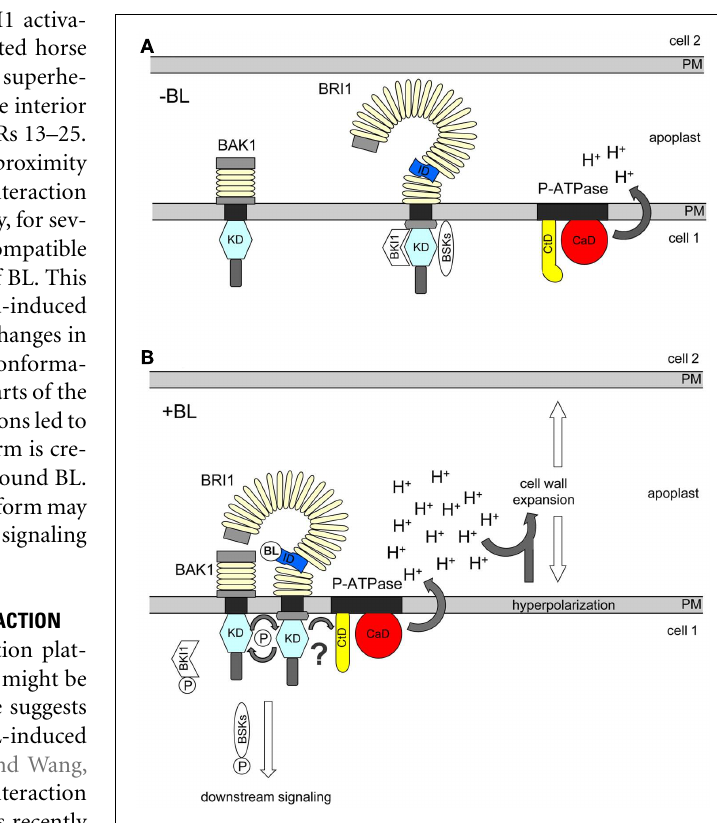
FIGURE 1 | Simplified model of the P-ATPase-independent (left) and P-ATPase-dependent, “short-cut” (right) BR response pathways in plant cells. (A) In the absence of BR, BRI1 is inhibited by its C-terminal domain and BKI1 and sequesters BSKs at the plasma membrane (PM). At this state, BRI1 might also be loosely associated with the P-ATPase (not shown). (B) After BL binding, BRI1 interacts with BAK1, phosphorylates BKI1, which is released into the cytoplasm.This promotes trans-phosphorylation between BRI1 and BAK1, establishment of the fully active BRI1/BAK1 signaling complex and the release of phosphorylated BSKs. Phosphorylated BSKs induce the signaling process leading to BR-controlled gene expression. BL binding also triggers the association of BRI1 with the P-ATPase.This suppresses the inhibition of the pump’s activity by its C-terminal domain (CtD) and results in the BRI1 kinase activity-dependent activation of the P-ATPase’s catalytic domain (CaD) by a yet unknown mechanism (?).The enhanced P-ATPase activity causes proton (H + ) extrusion into the apoplast and hyperpolarization of the PM leading to cell wall expansion. For the full BL-induced expansion response a further, yet unknown component is required in addition to PM hyperpolarization and apoplast acidification (not included). It is unclear whether association with BAK1, release of phosphorylated BKI1 or BKSs and/or